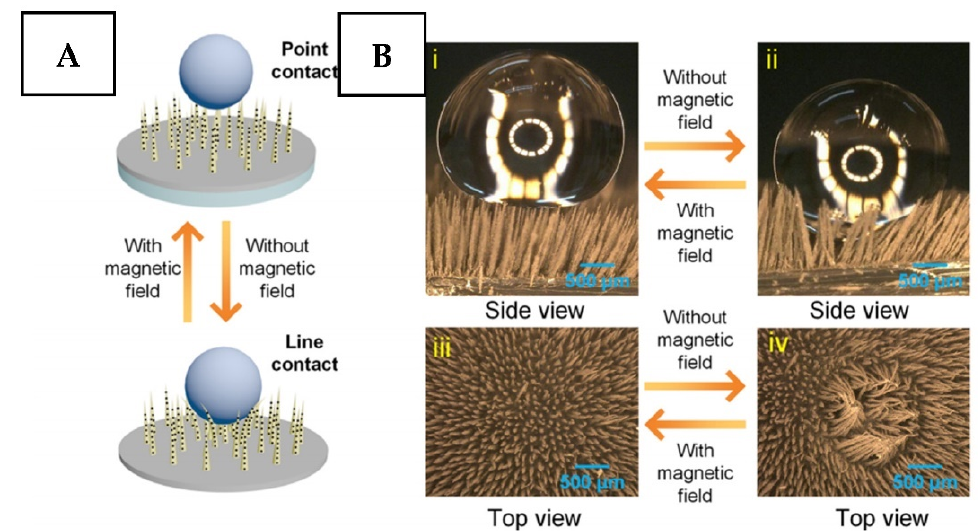
Figure 8. ( A ) A scheme for reversible switching of wettability and adhesion properties of the magnetically responsive superhydrophobic surface by on/off switching of the magnetic field. ( B ) Optical microscope images show the stiffness tunability of the magnetorheological elastomer micropillars under an external magnetic field, which can transform the micropillars from the collapsed morphology (water-adhesive state) to the fully upright position (water-repellent state). Reprinted with permission from ref. [121]. Copyright 2018 American Chemical Society.